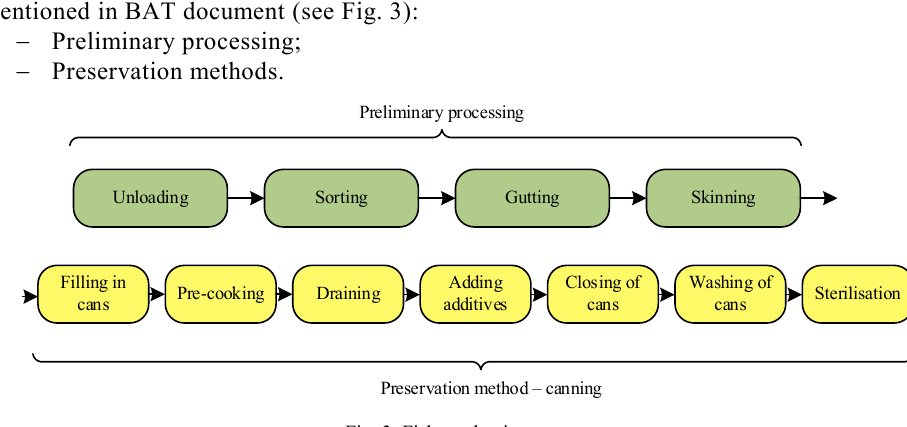
Fig. 3. Fish production